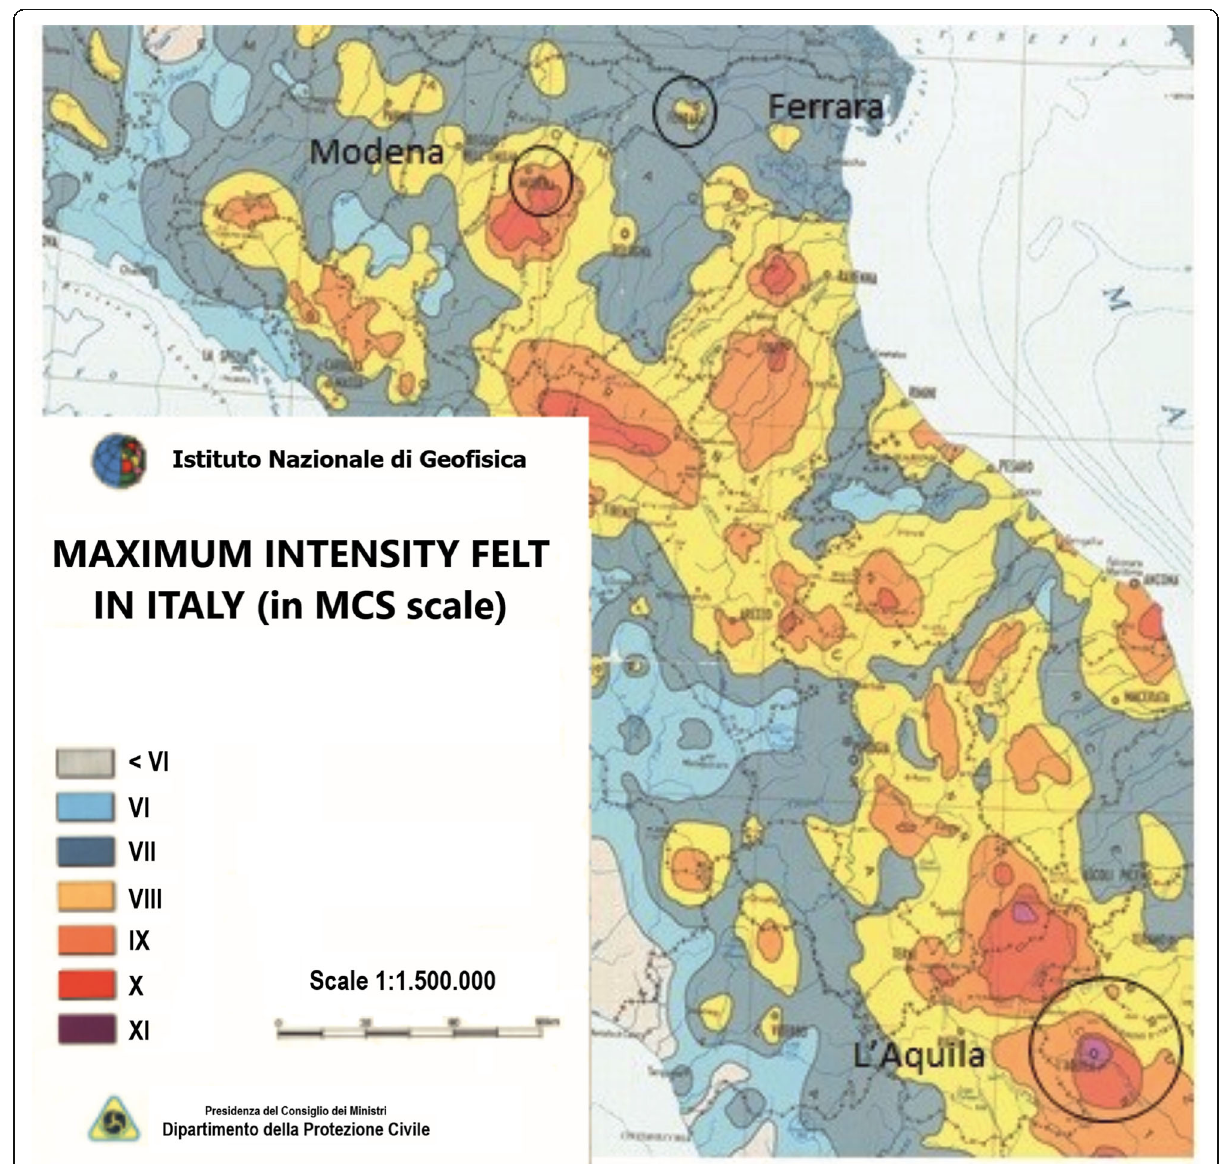
Fig. 1 Italian Maximum Intensity felt map (After Boschi et al. 1995, modified) with the areas of two recent Italian earthquake sequences considered in the present